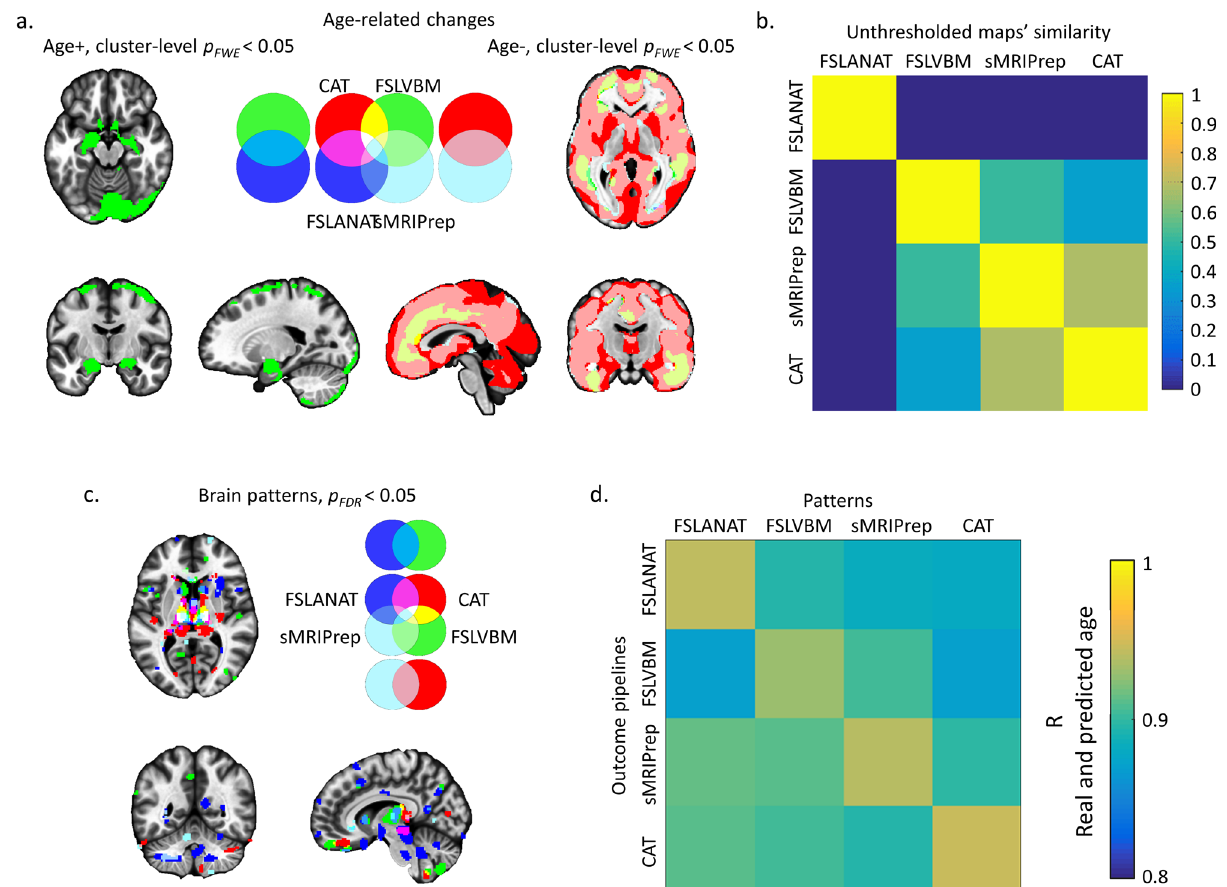
Fig. 4 Univariate and multivariate analyses with respect to age-related GMV changes. a Results displaying the overlap between pipelines at a cluster- level p FWE < 0.05 with initial cluster forming voxel level p < 0.001. The left panels of a depict brain regions with increasing GMV with age. The right panels of a depict decreases with age. For a and d the pipelines are coded as: red = CAT, green = FSLVBM, blue = FSLANAT, light blue = sMRIPrep, additional colors visualize the overlap between the results, e.g., CAT ∩ FSLVBM = yellow, CAT ∩ FSLANAT = purple, FSLVBM ∩ FSLANAT = light blue, CAT ∩ FSLVBM ∩ FSLANAT = white and etc. b The variability of unthresholded statistical maps. The correlation values between whole-brain unthresholded statistical maps of four pipelines were computed, respectively, for age-related effects. Only positive values are visualized for display purpose. c Reliable brain patterns to predict age determined by bootstrapping tests (5000 permutations, p FDR < 0.05), and d cross-predicted r value of four pipelines for each of the pipeline proprocessed samples. The color from cold to warm indicates increasing r values (from 0.8 to